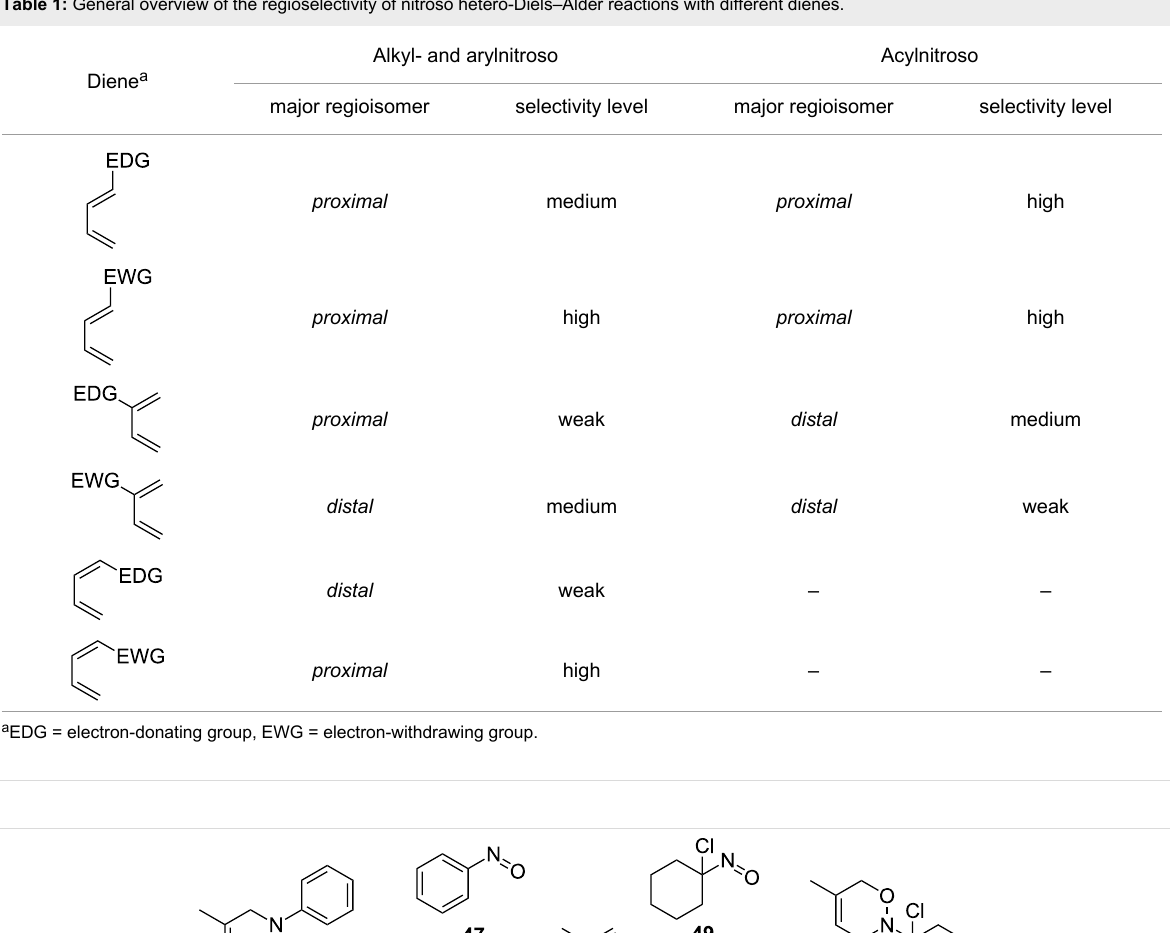
Table 1: General overview of the regioselectivity of nitroso hetero-Diels–Alder reactions with different dienes.